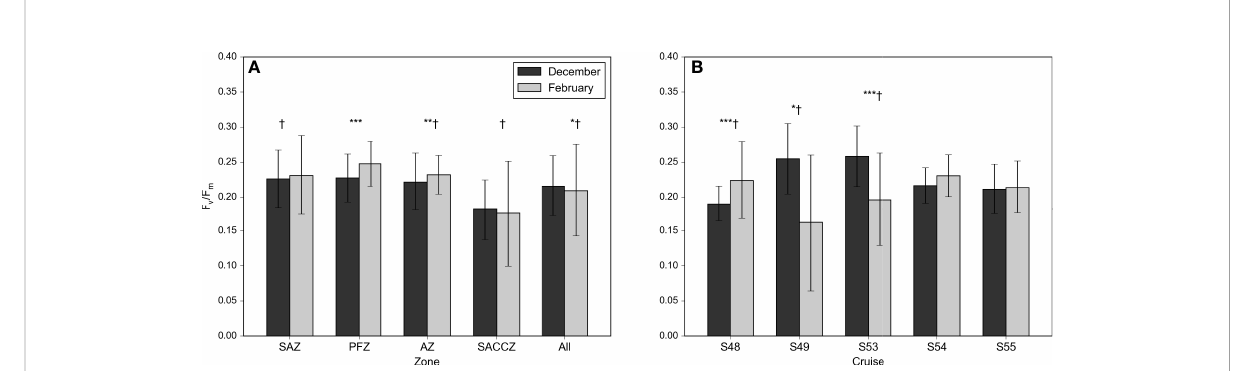
FIGURE 4 Intra-seasonal (early vs late summer) variability of F v /F m across (A) each zone and (B) per cruise in December and February. Error bars represent standard deviations. The overall mean F v /F m across all zones per season is shown as “ All ” in (A) . Signi fi cant differences are represented as *p<0.05, **p<0.01 and ***p<0.001. Signi fi cant differences are represented as *p<0.05, **p<0.01 and ***p<0.001, while † represents unequal variance where a Welch ’ s t-test was